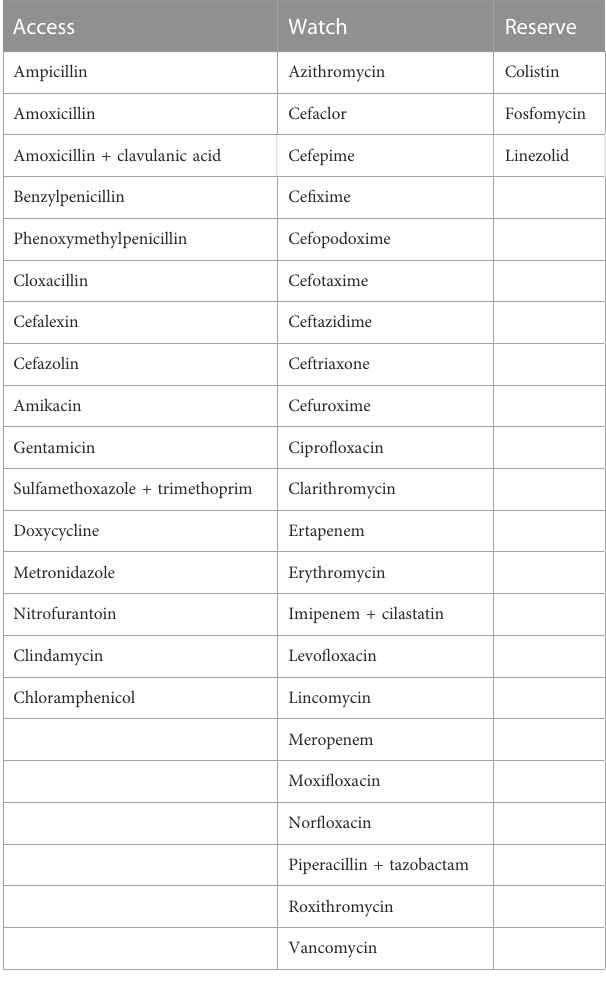
TABLE 1 List of antibiotics available in HSAL categorized by the AWaRe classi fi cation.